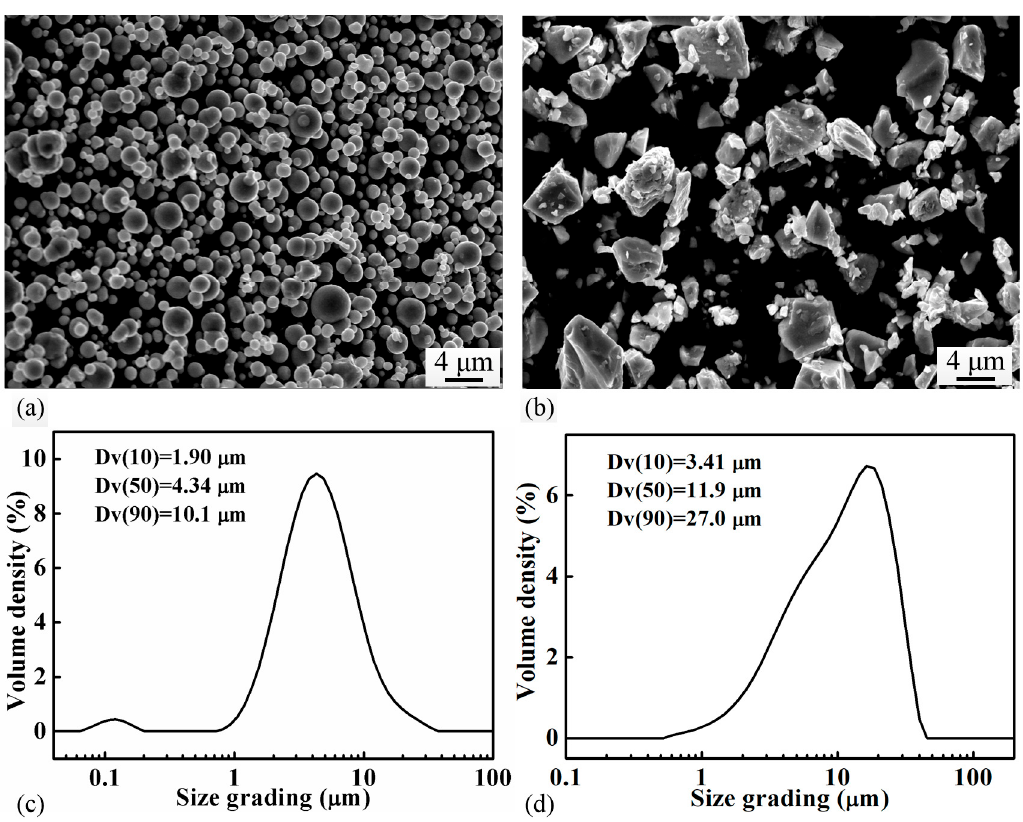
Figure 1. Micrographs showing the morphology of ( a ) the carbonyl iron powder, ( b ) the Fe 3 P powder; and particle size distribution of ( c ) the carbonyl iron powder, ( d ) the Fe 3 P powder.